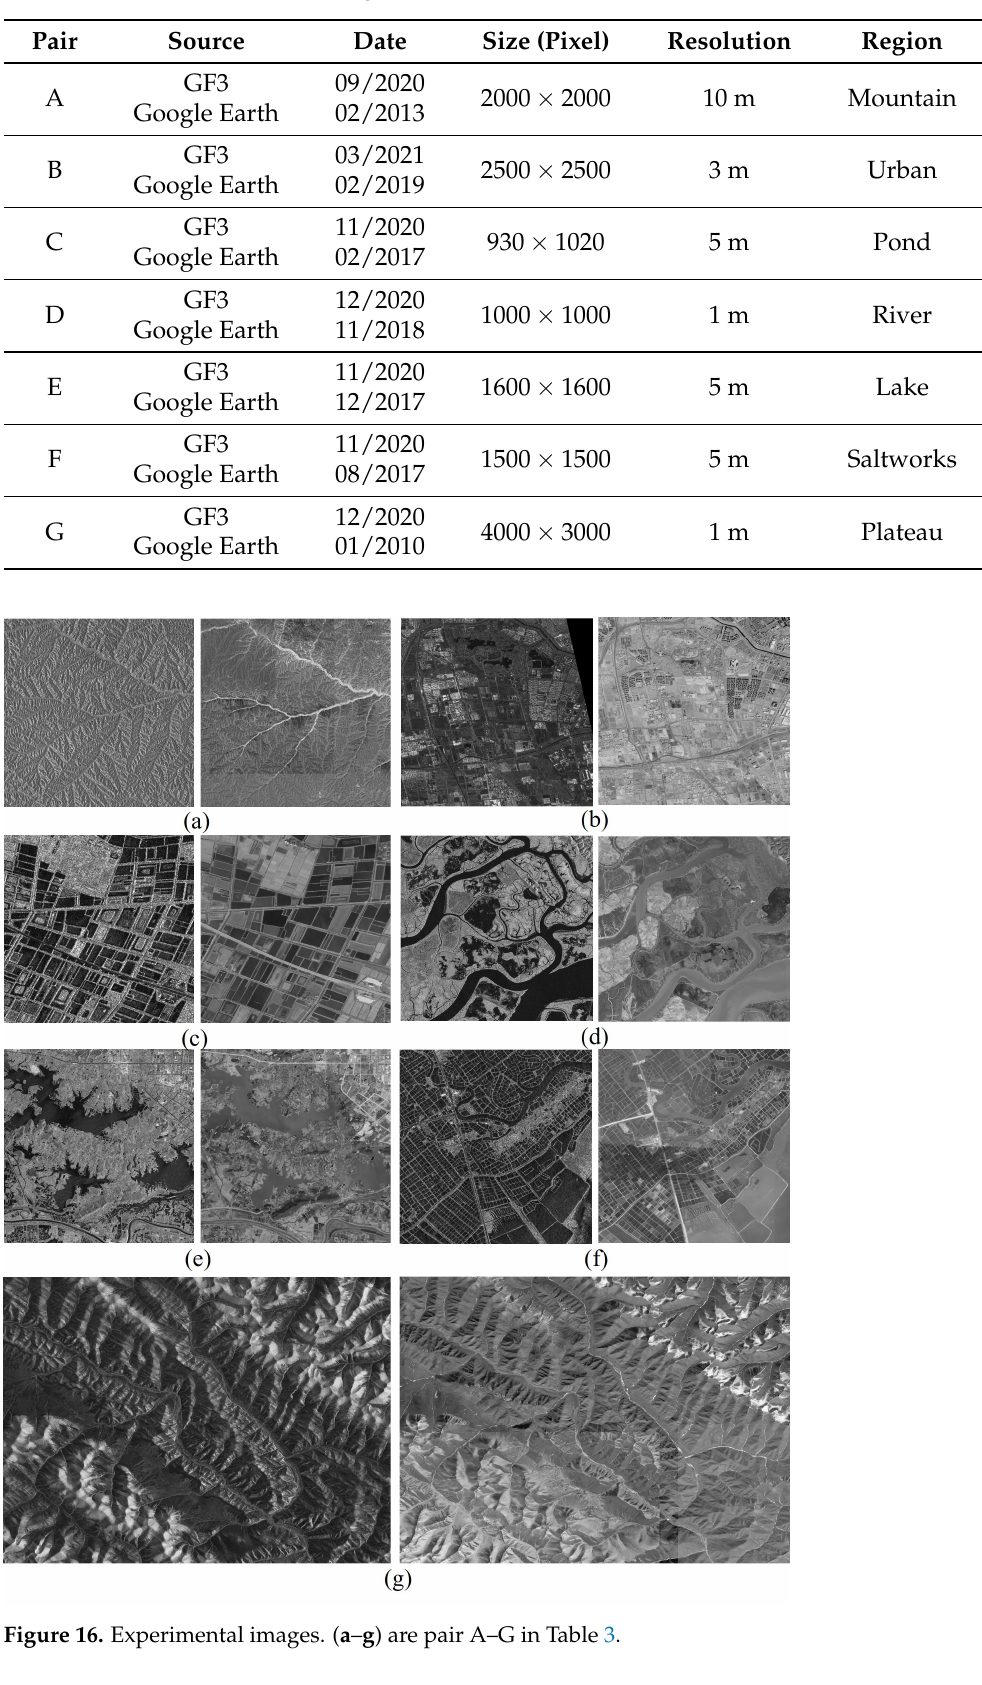
Table 3. Information for the test images.